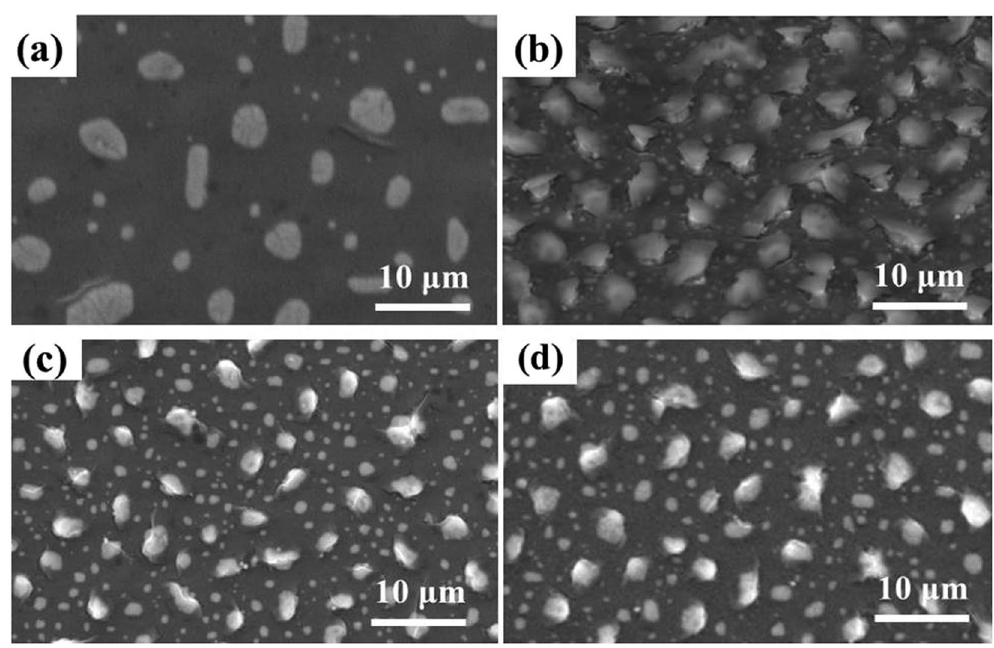
Figure 4. FESEM images of PMA with different thermal annealing temperature. Thermal annealing temperature is at ( a ) 500 °C, ( b ) 600 °C, ( c ) 700 °C, and ( d ) 800 °C, respectively (All Au layers are kept at 20 nm in